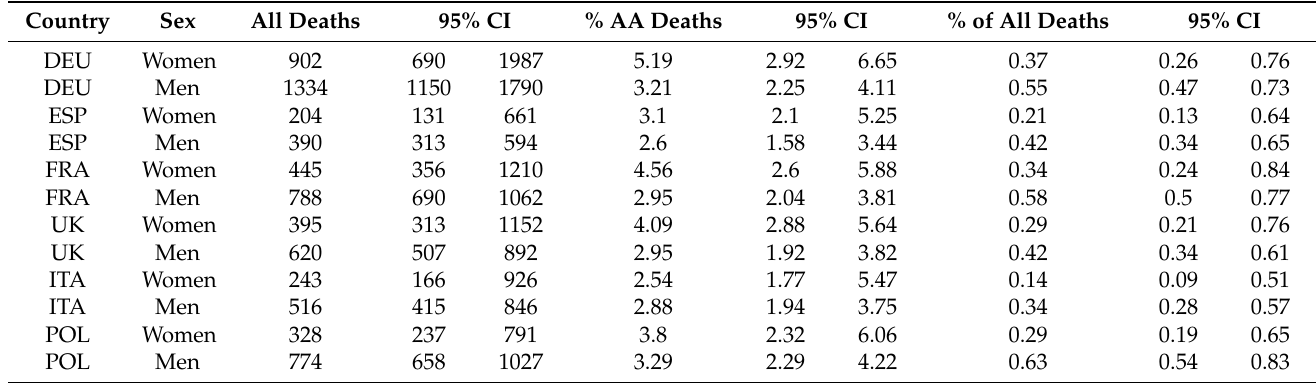
Table A5. Averted deaths by a reduction of alcoholic strength in 2019 (5% reduction of alcoholic strength).